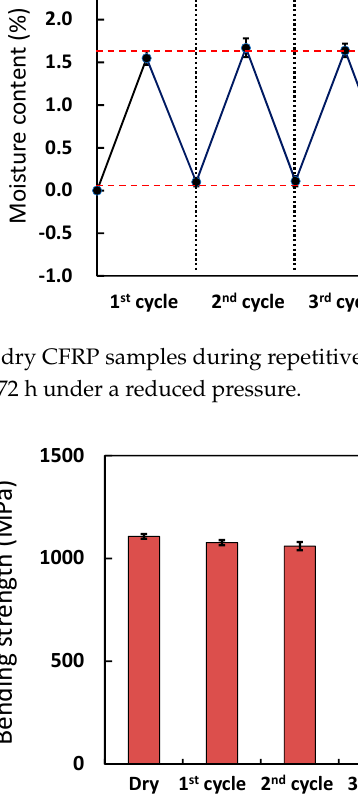
Figure 8. Bending strength of CFRP samples during repetitive moisture absorption at 120 °C and drying.